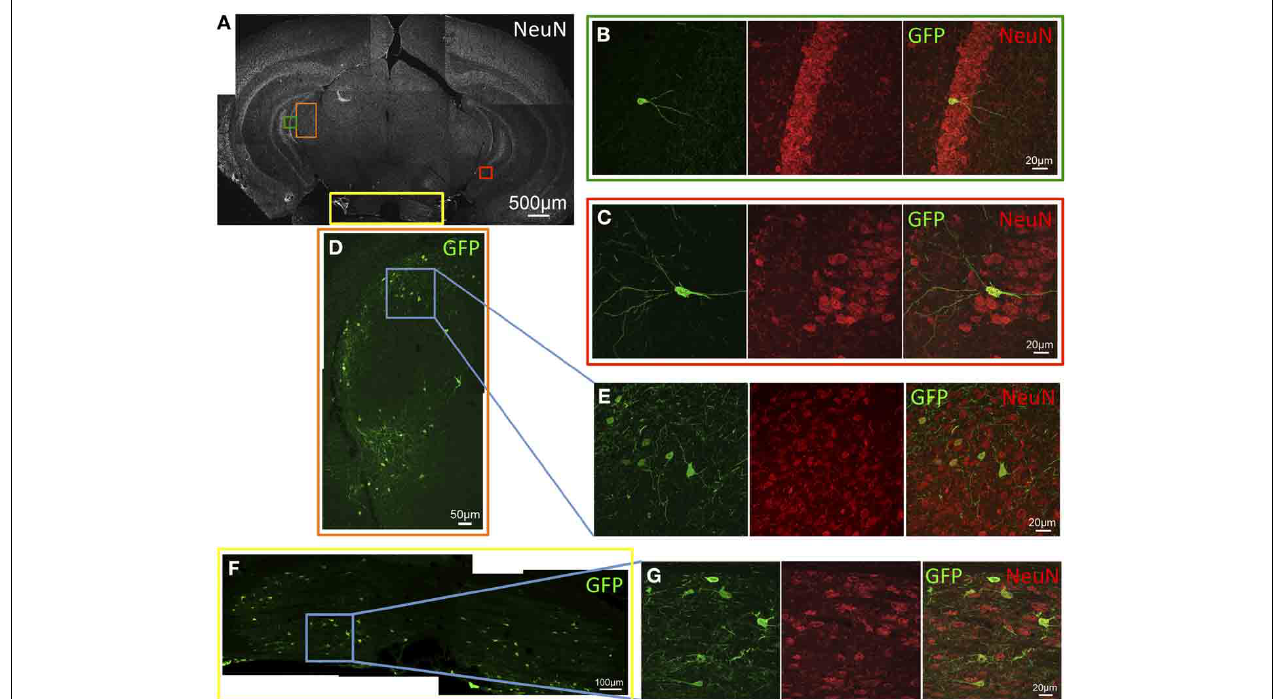
FIGURE 5 | GFP-ir in the caudal thalamus, hippocampal formation, and pons. (A) Low magnification image of NeuN-ir and colored inset boxes illustrate the locations of images in B-G (approximately − 3.0mm Bregma). (B–G) Green shows GFP-ir, red shows NeuN-ir, and merged images illustrate co-localization in yellow. (B) A GFP-positive neuron in the granular layer of the dentate gyrus. (C) A GFP-positive neuron in